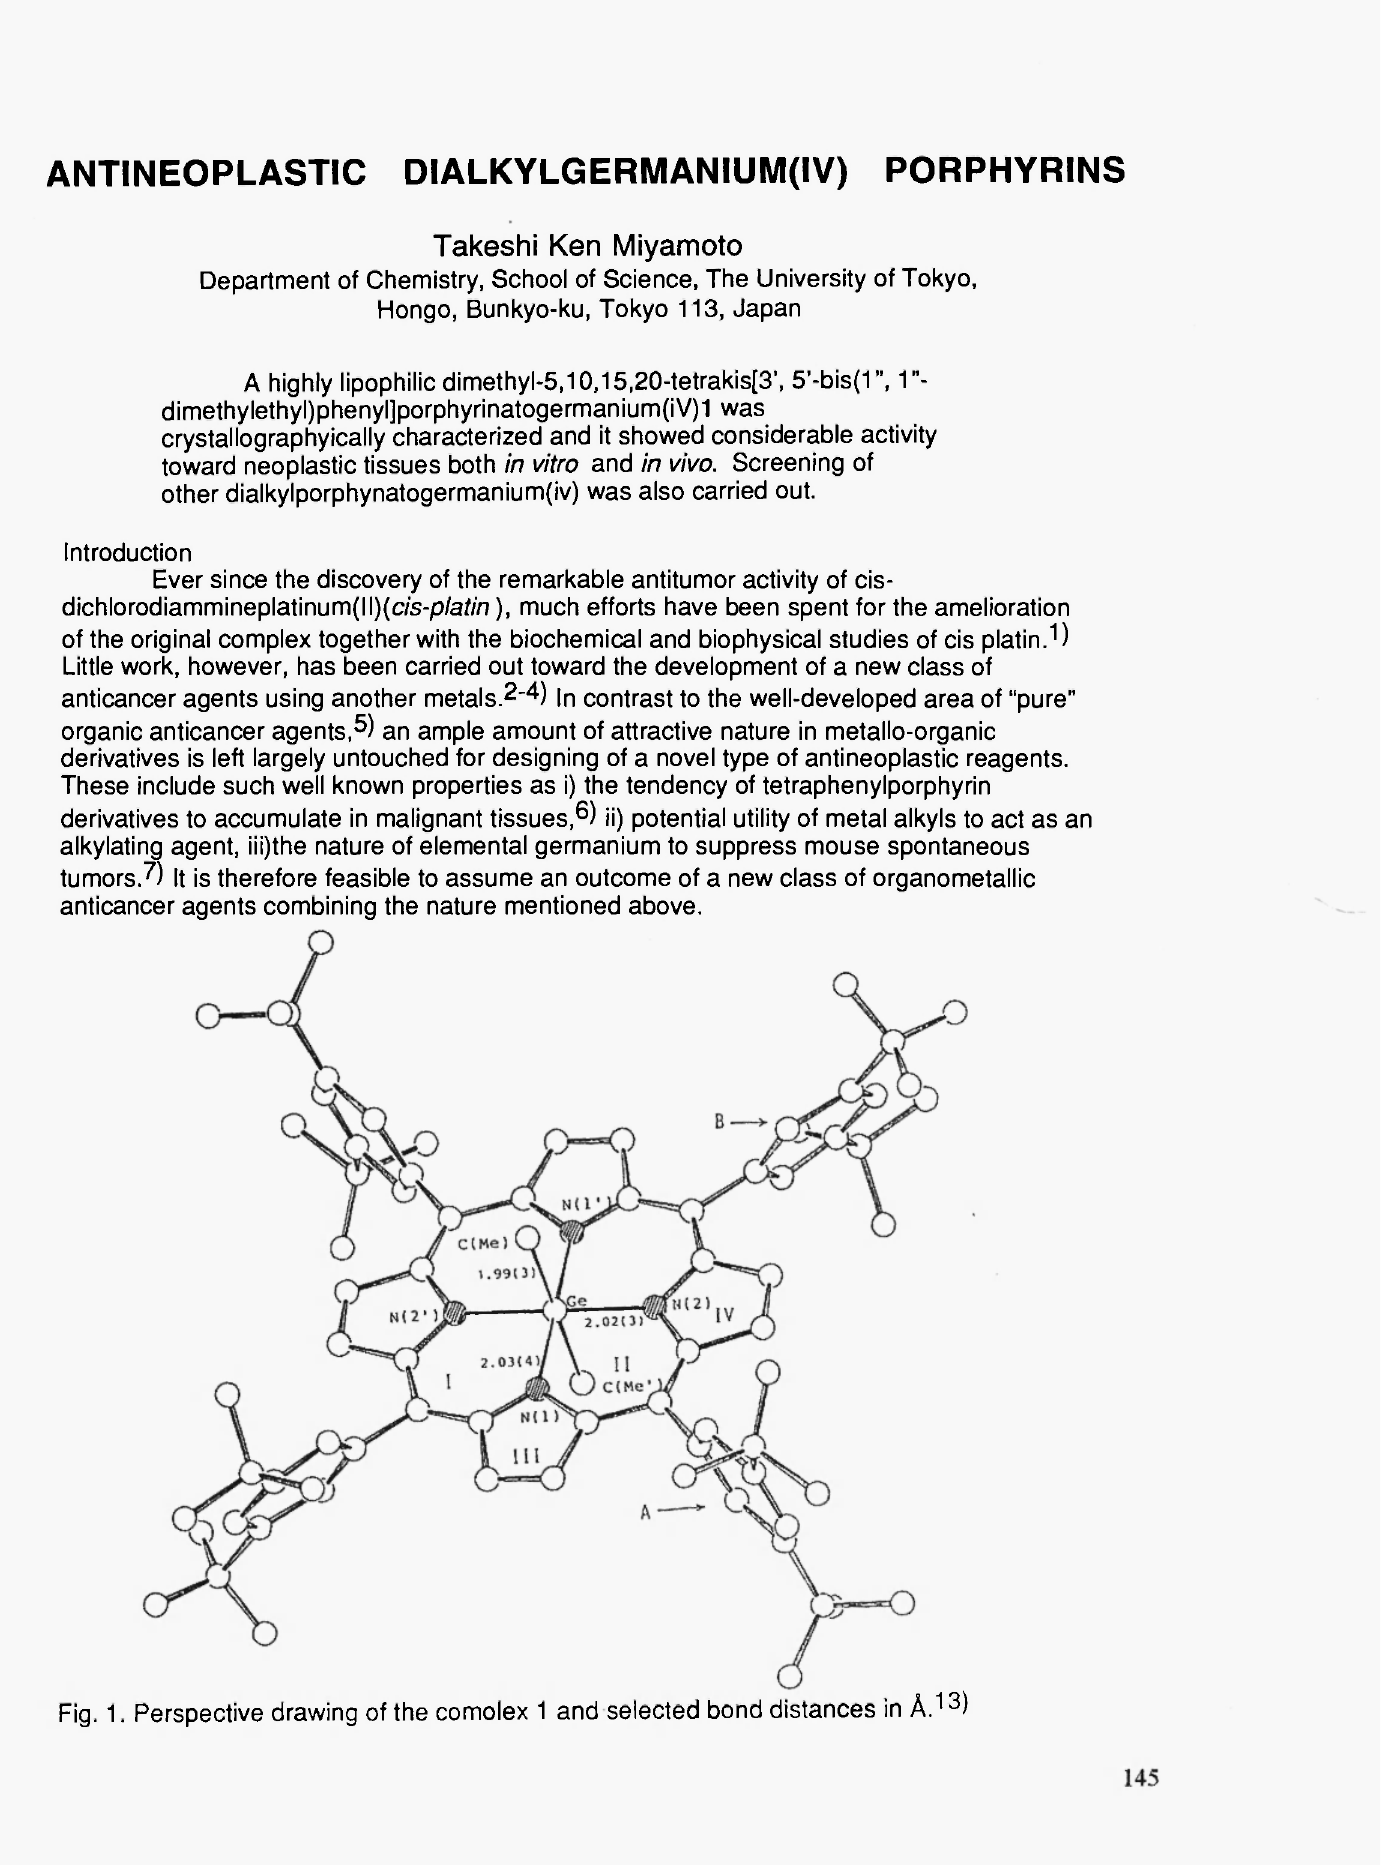
Fig. 1. 1 Perspective drawing of the comolex and selected bond distances in